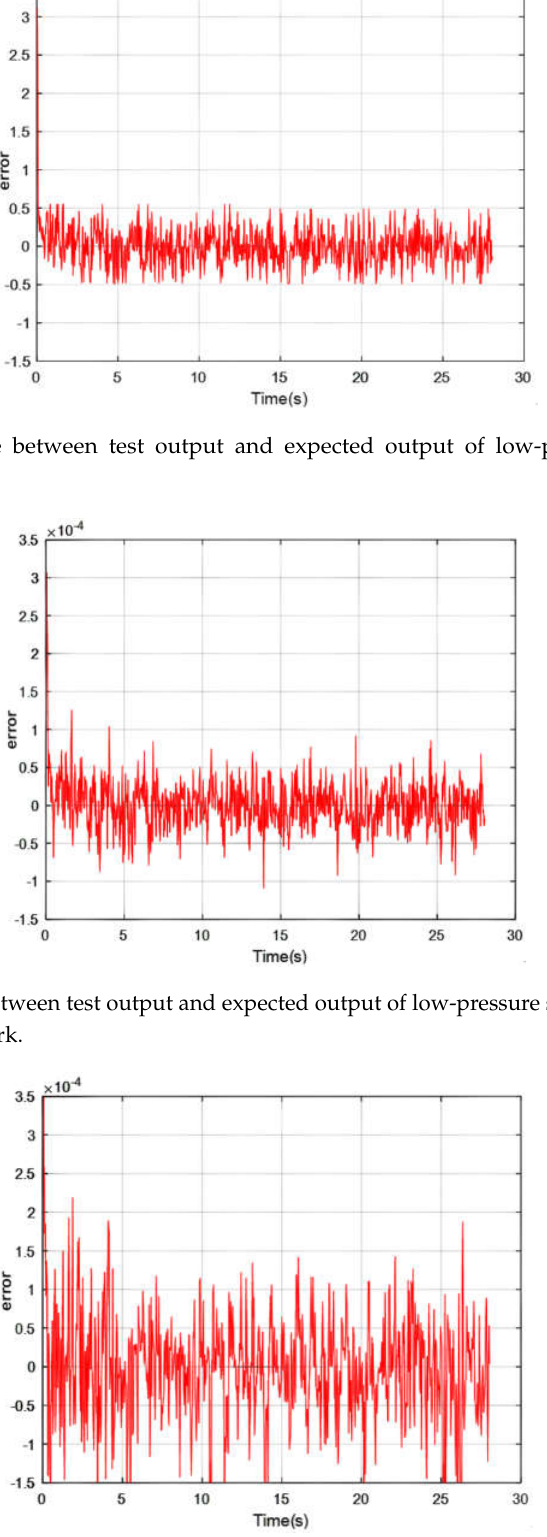
Figure 8. Error curve between test output and expected output of low-pressure spool speed under the conventional BP neural network.